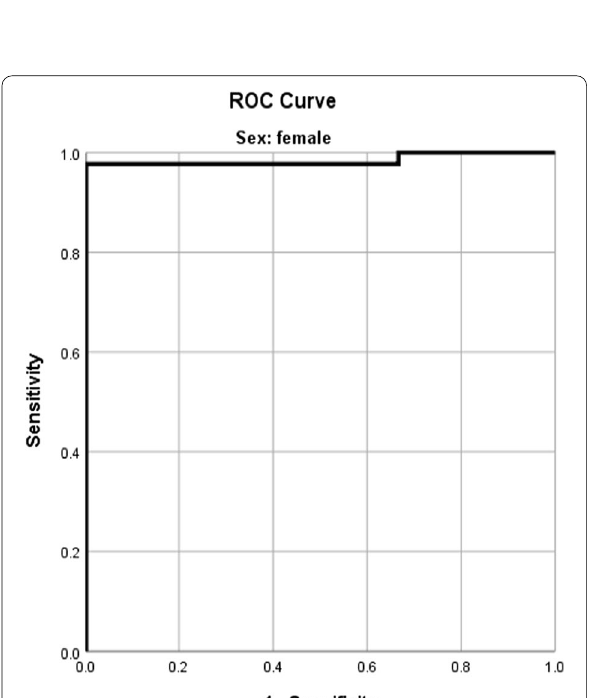
Fig. 12 Cut off value of female quadriceps